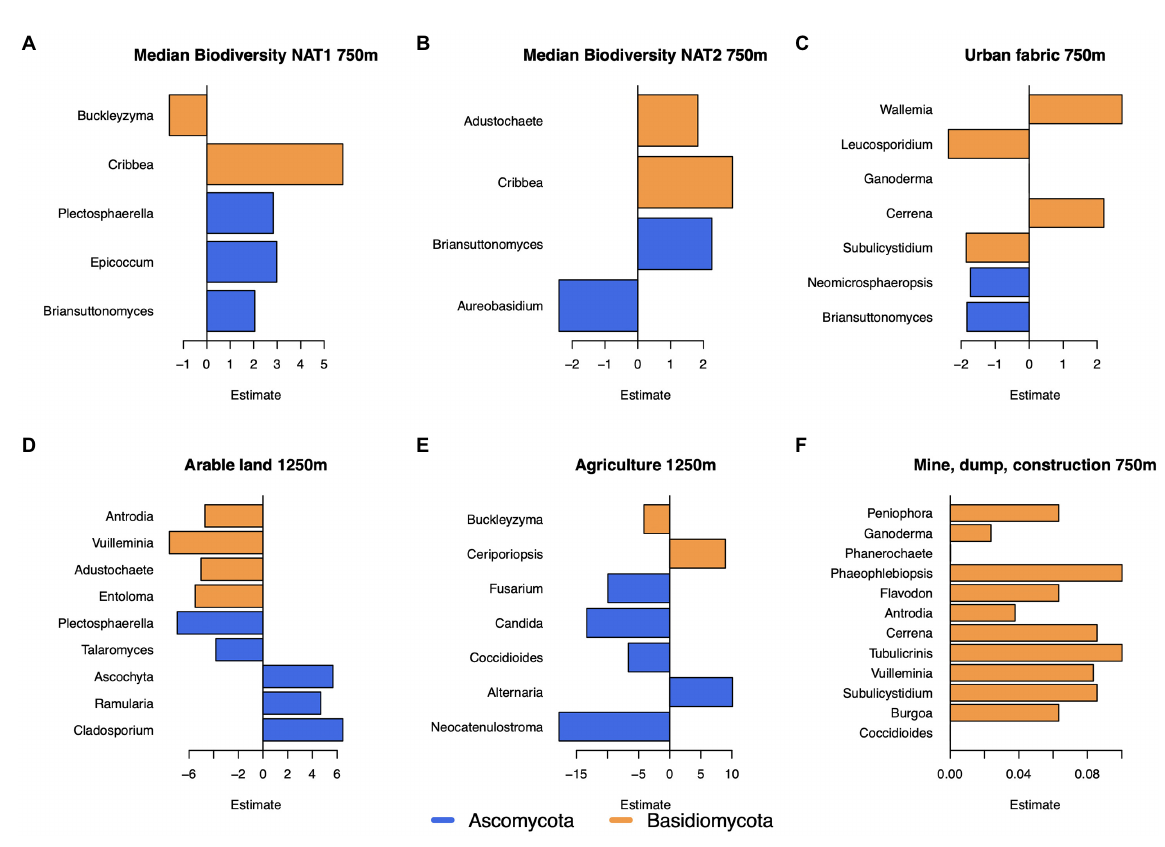
FIGURE 5 The estimated effect of the environement on fungal genera. (A) The median biodiversity (NAT1) within 750m, (B) the median biodiversity (NAT2) within 750m, (C) the degree of urban fabric within 750m, (D) the degree of arable land within 1250m, (E) the degree of agriculture within 1250m, and (F) the degree of mine, dump, or construction sites within